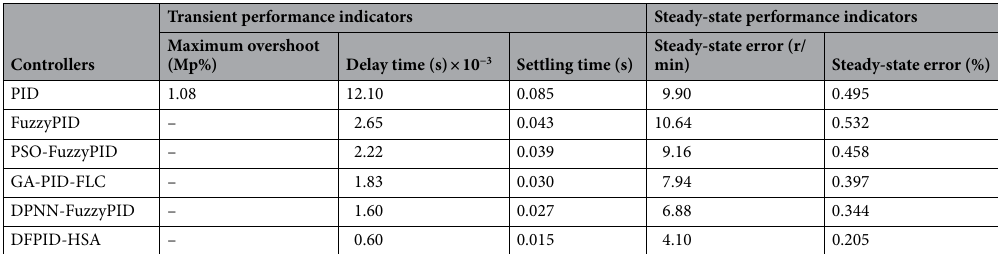
Table 7. The comparison of performance indicators under the no-load condition. Mp% = [Speed (max) − Speed (∞)]/Speed (∞) × 100%.